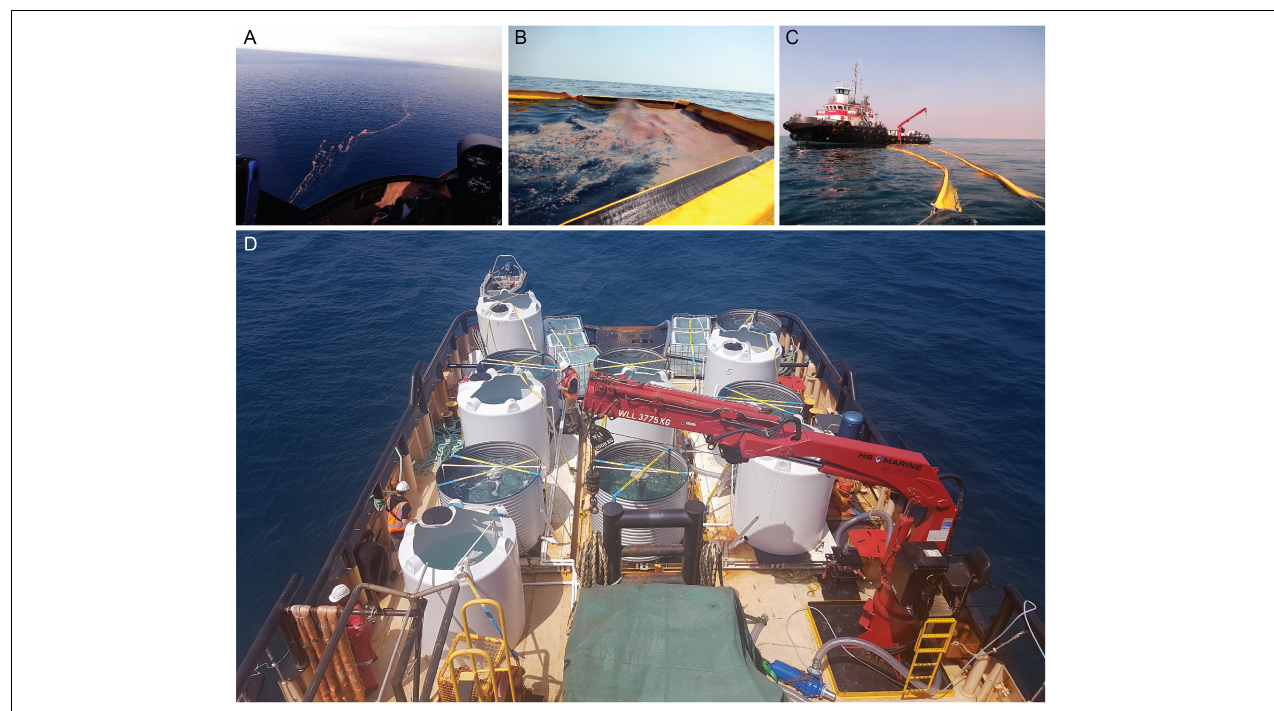
FIGURE 1 | Testing the feasibility of operationalizing the spotting, containing, collecting, and culturing of coral-spawn slicks at industrial-scales. (A) View of a spawn slicks in the open ocean from a helicopter. (B) Containing coral-spawn slick in an oil boom for (C) collection onto the tugboat. (D) Overview of the back deck of the tugboat with the 4,500 L steel ( n = 6) and plastic ( n = 6)